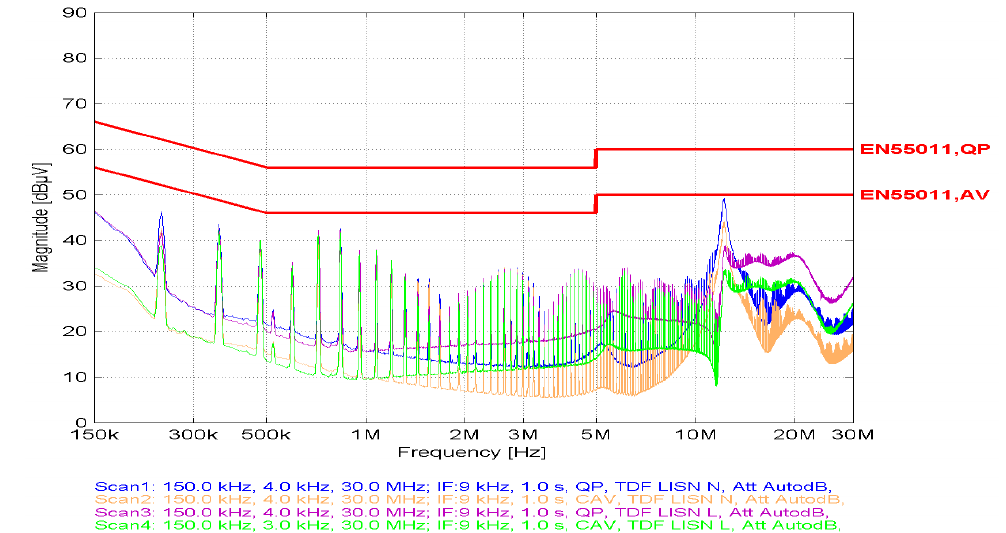
Figure 8. Attenuation level for ferrite No. 1 with the number of coils at 15 pcs. In the case of tests for 10 pieces of coils, it can be seen that the maximum values in the frequency range of 12–15 MHz exceed the defined AV limit by approx. 2 dB. Therefore, an attempt was made to carry out tests for 12 pieces of coils (Figure